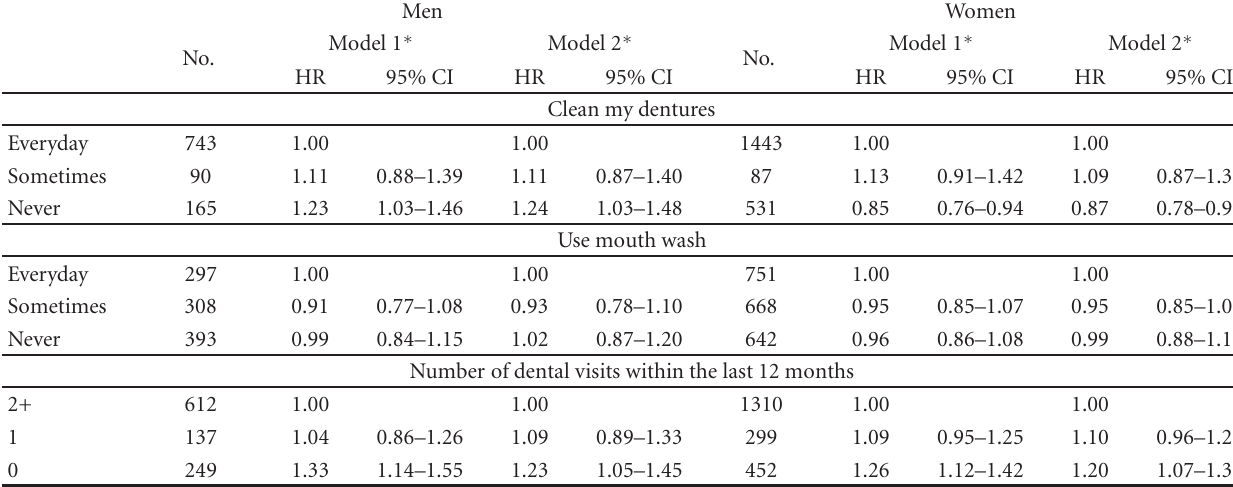
Model 2: adjusted for age at entry, smoking, alcohol, ca ff eine, active activities, other activities, body mass index, high blood pressure, angina, heart attack, stroke, diabetes, rheumatoid arthritis, and